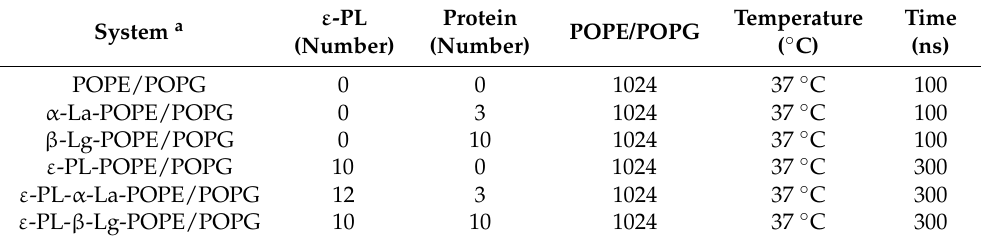
Table 2. The parameters of the bilayer membrane molecular dynamics (MD) simulation.